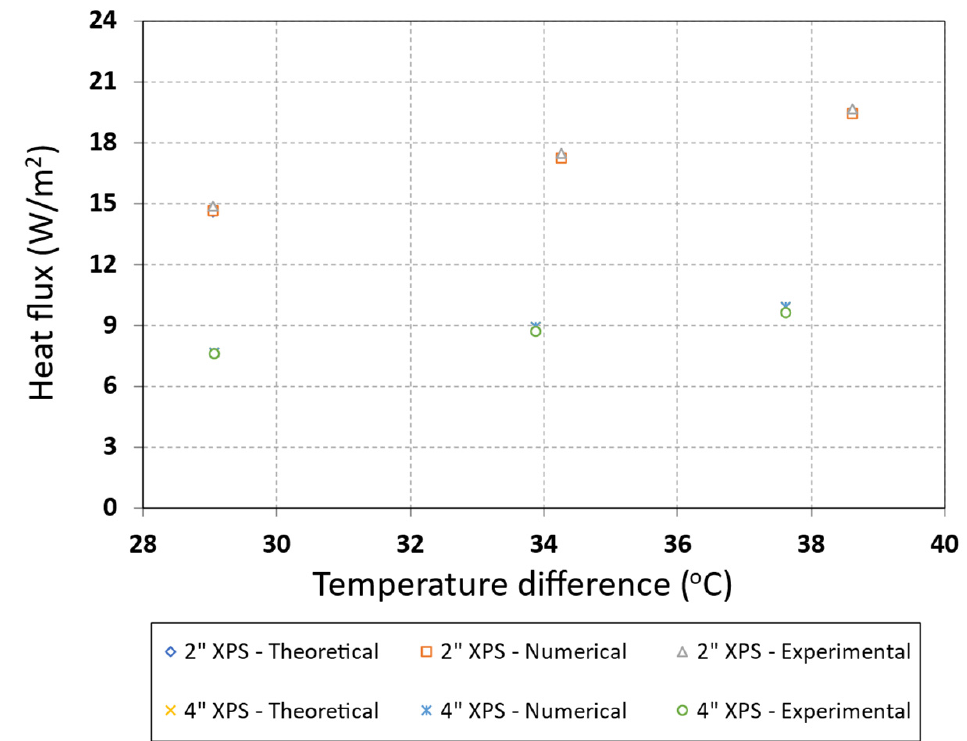
Figure 8. Comparison between theoretical, numerical, and experimental heat flow rates.